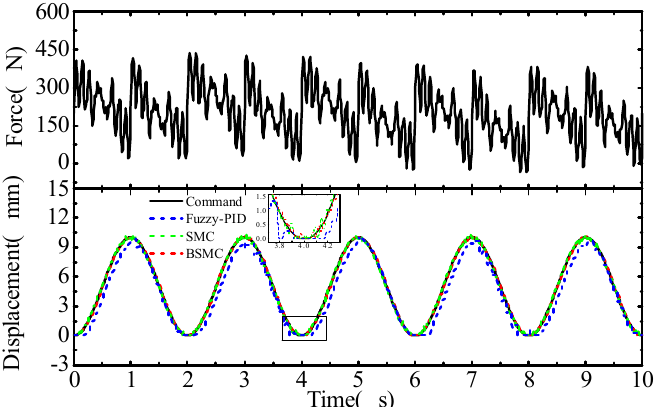
Figure 9. Sine response of the cylinder under random sinusoidal load. Figure 10 shows the tracking error of the sinusoidal response of the hydraulic cylinder under random load. The maximum tracking error of the system under fuzzy PID control can reach 1.5 mm and the load fluctuation range is large. The error fluctuation range under backstepping sliding-mode control is small, which indicates the good tracking performance of the hydraulic cylinder.